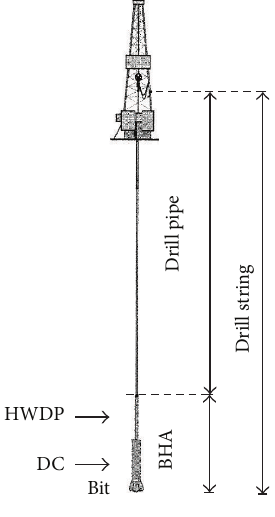
Figure 1: Drill string components [8].